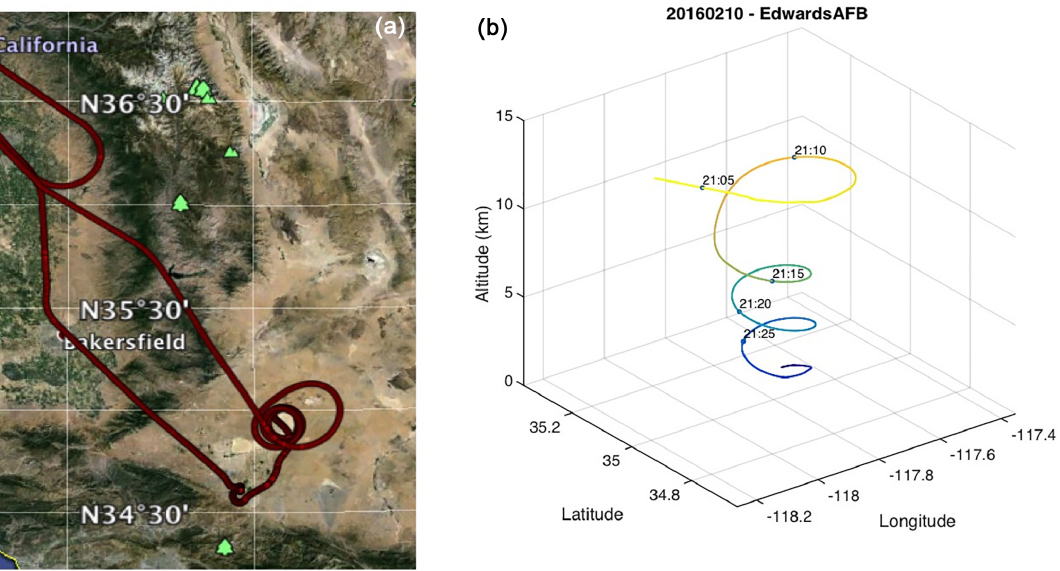
Figure 22. (a) Flight track for 10 February 2016 flight over Edwards AFB, California. (b) Time-tagged location and altitude plot for the spiral-down maneuver over Edwards AFB for the same